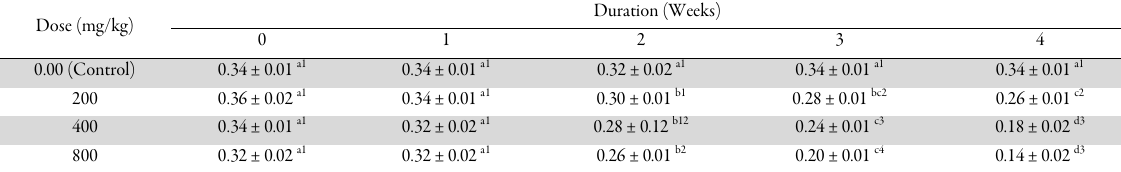
Table 5. Effect of Lipton tea aqueous extract on VLDL- C (mmol/l) of normal albino rats Dose (mg/kg) 0.00 (Control)